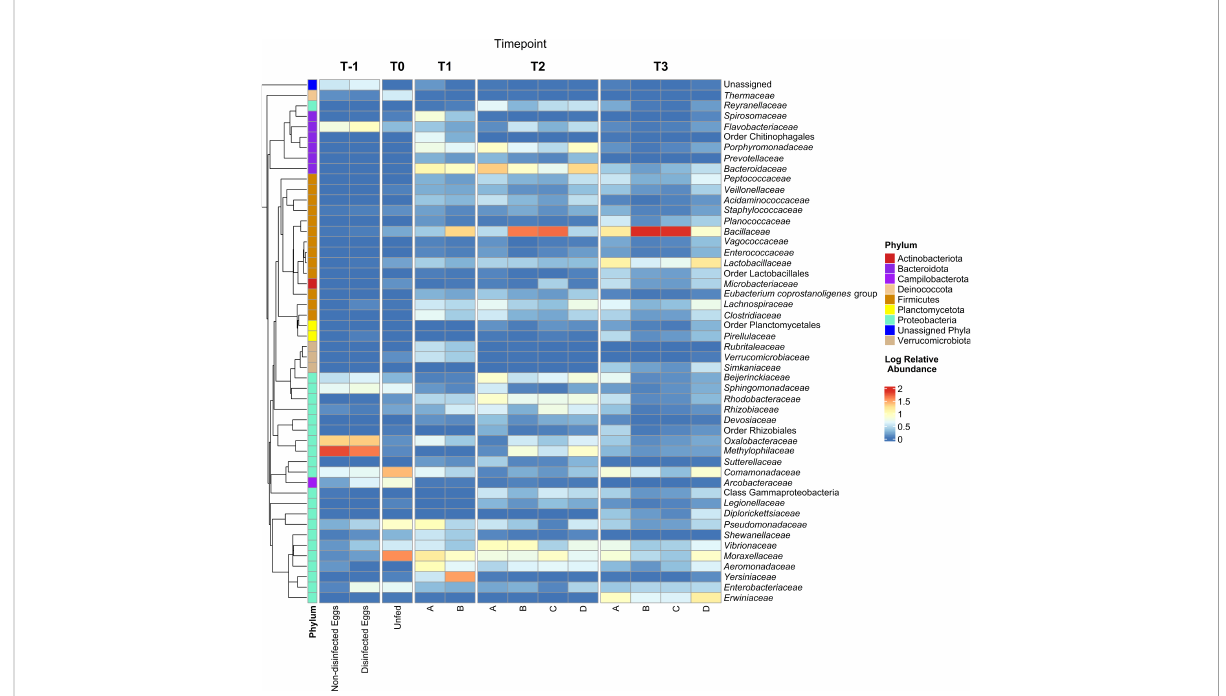
FIGURE 3 Family-level taxonomy of the internal bacterial microbiome of steelhead trout throughout a probiotic feeding regime. Following ampli fi cation of the 16S rRNA gene V4 region from fi sh internal GI samples collected at various timepoints during the early lifecycle of steelhead trout and fed one of four different diets (A, B, C, or D) or unfed eggs, the amplicons were sequenced via Illumina MiSeq. The log relative abundance of family- level taxa is plotted here. ASVs without family-level assignment are designated the higher classi fi cation as necessary. A QIIME2-generated phylogenetic tree was used to denote the phylogeny and phylum to which each family-level taxon